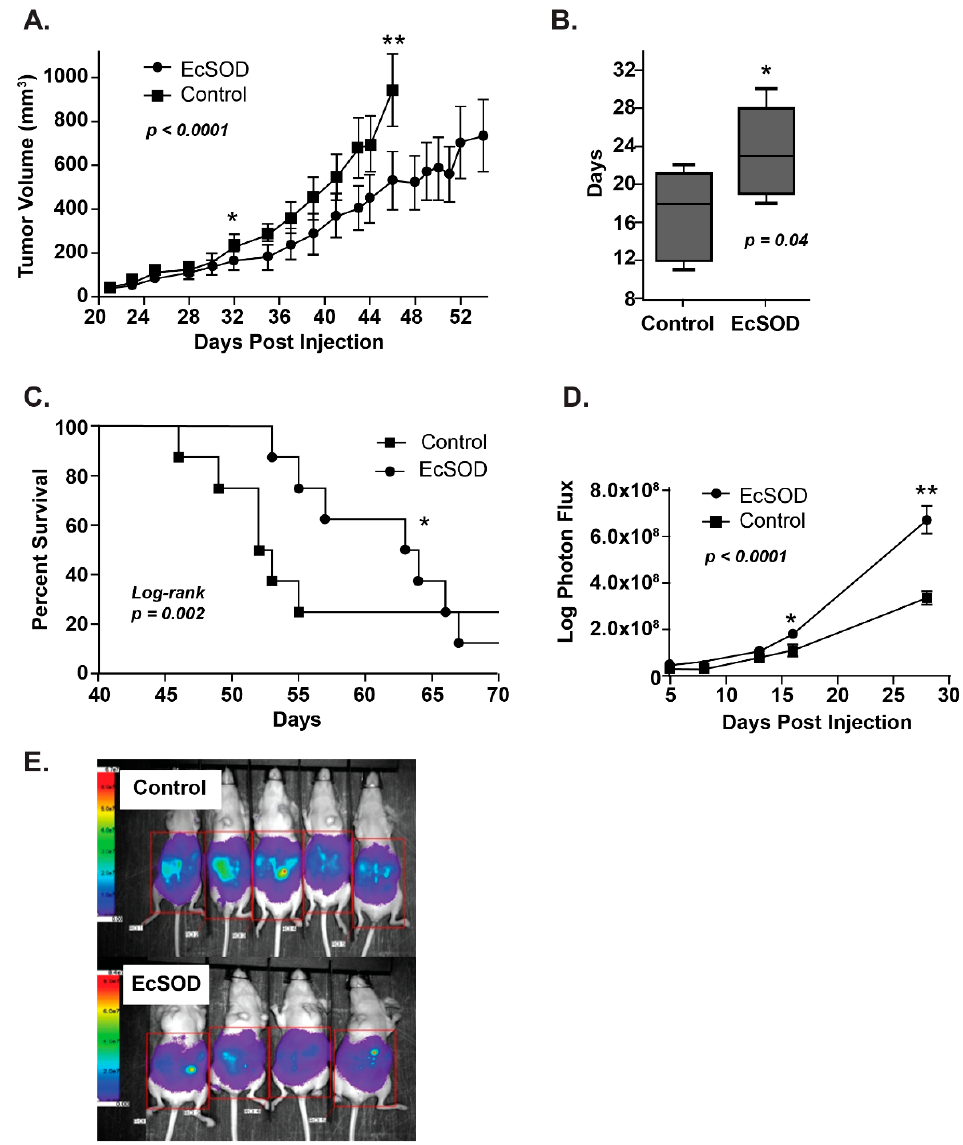
Figure 3. Overexpression of EcSOD reduces tumor xenograft growth and peritoneal growth and increases doubling time and animal survival in athymic nude mice. ( A ) EcSOD overexpressing-tumor volumes were significantly smaller (** p < 0.05 vs. EcSOD) starting on day 32. ( B ) EcSOD tumors demonstrated a significantly longer doubling time compared to the control (* p < 0.05 EcSOD vs. control). ( C ) Kaplan–Meier survival plot demonstrates that mice baring EcSOD, expressing BxPC3 tumors had prolonged median survival compared to mice baring empty vector tumors (63 vs. 52 days * p = 0.002, log-rank). ( D ) Intraperitoneal luciferase-expressing EcSOD tumors demonstrated decreased growth measured by total photon flux when compared to empty vector control tumors.